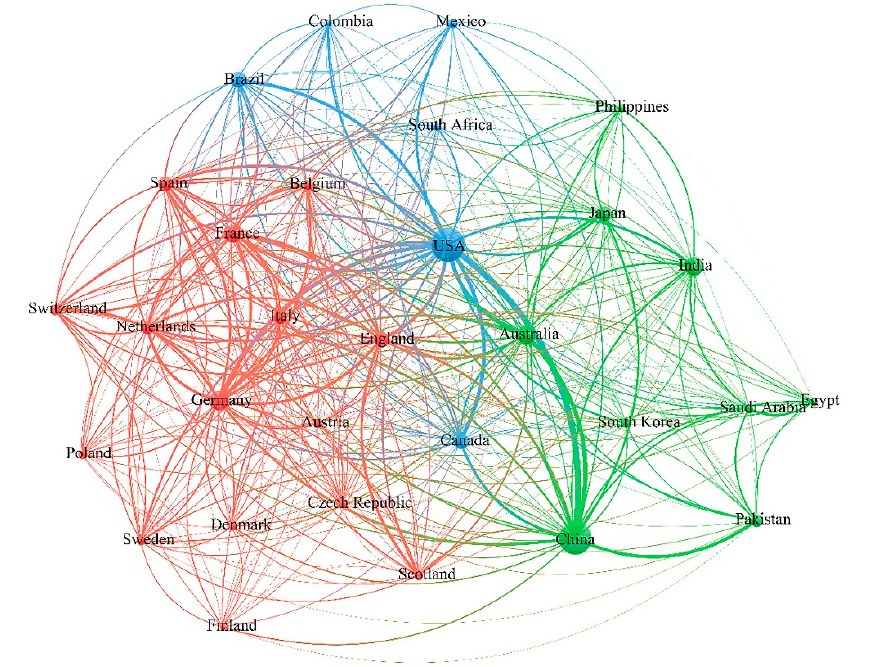
Figure 5. Core international collaboration network map of the top 30 countries from 2000 to 2021. The size of nodes indicates the number of published articles, the connection thickness between nodes indicates the degree of cooperation between authors and the color of different nodes indicates different clustering results.